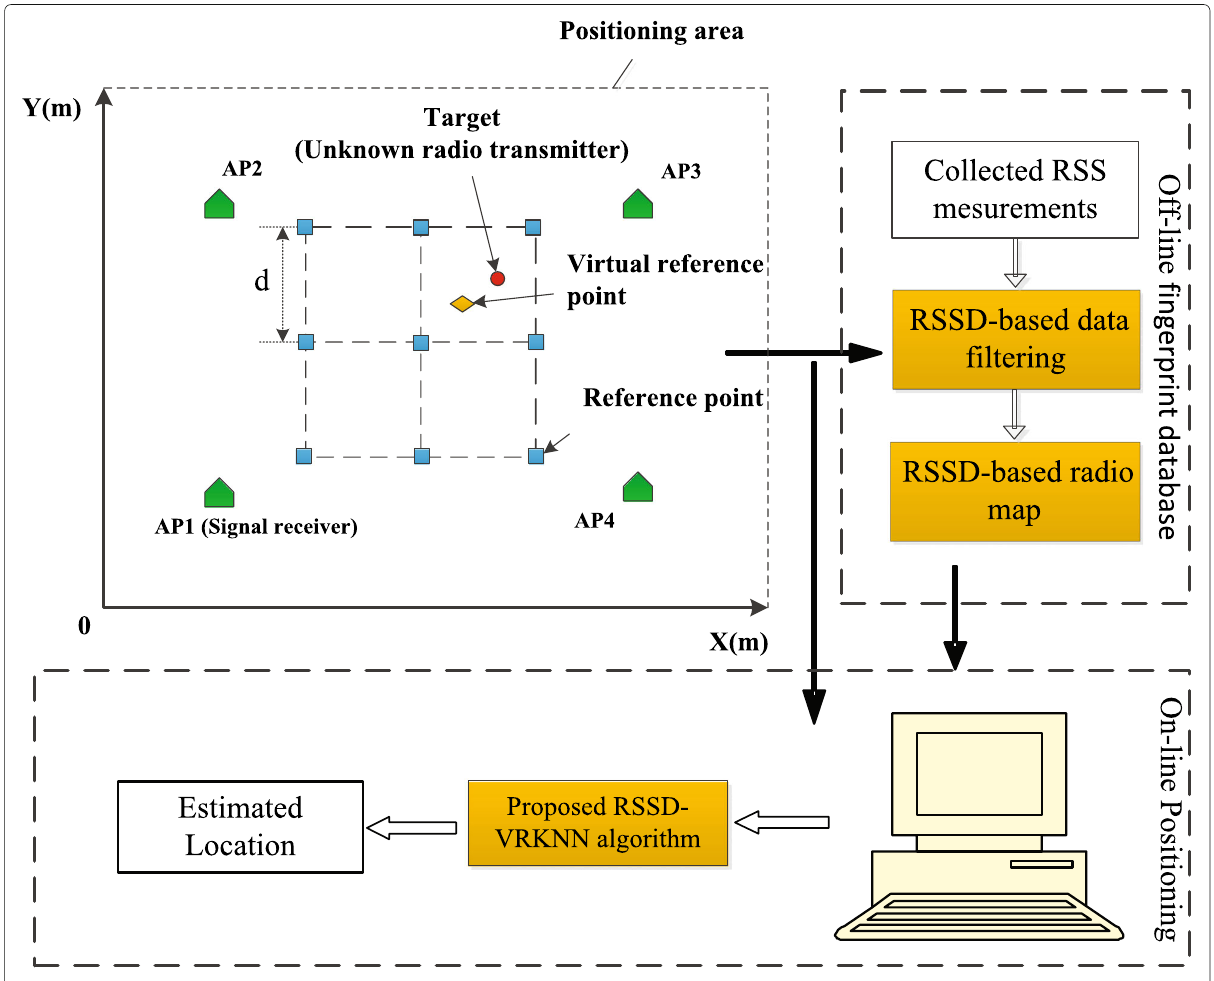
Fig. 1 Structure of the proposed RSSD-VRKNN positioning system. Four APs and an unknown radio transmitter (the positioning target) are used in this system